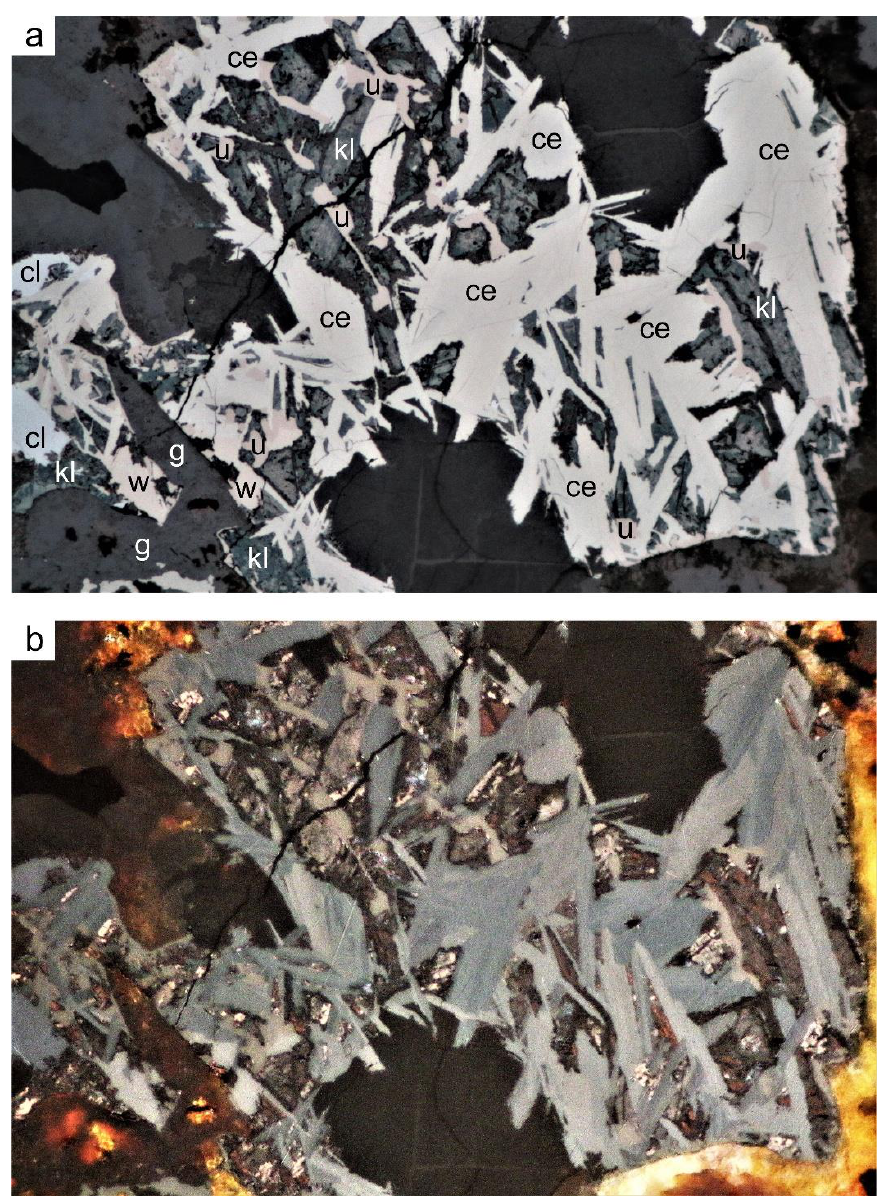
Figure 7. Type-II cerromojonite associated with klockmannite, unnamed CuNi 2 Se 4 , clausthalite, and later-formed goethite in reflected light: ( a ) 1 polarizer, ( b ) partially crossed polarizers. Horizontal field of view is 200 µm. Abbreviations: ce = cerromojonite, kl = klockmannite, w = watkinsonite, cl = clausthalite, u = unnamed CuNi 2 Se 4 , g = goethite.